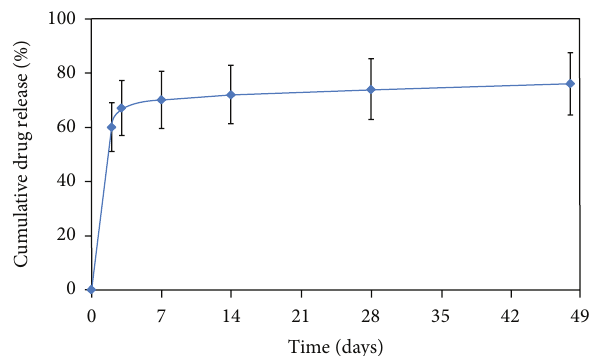
Figure 1: In vitro drug release from the Indolimus